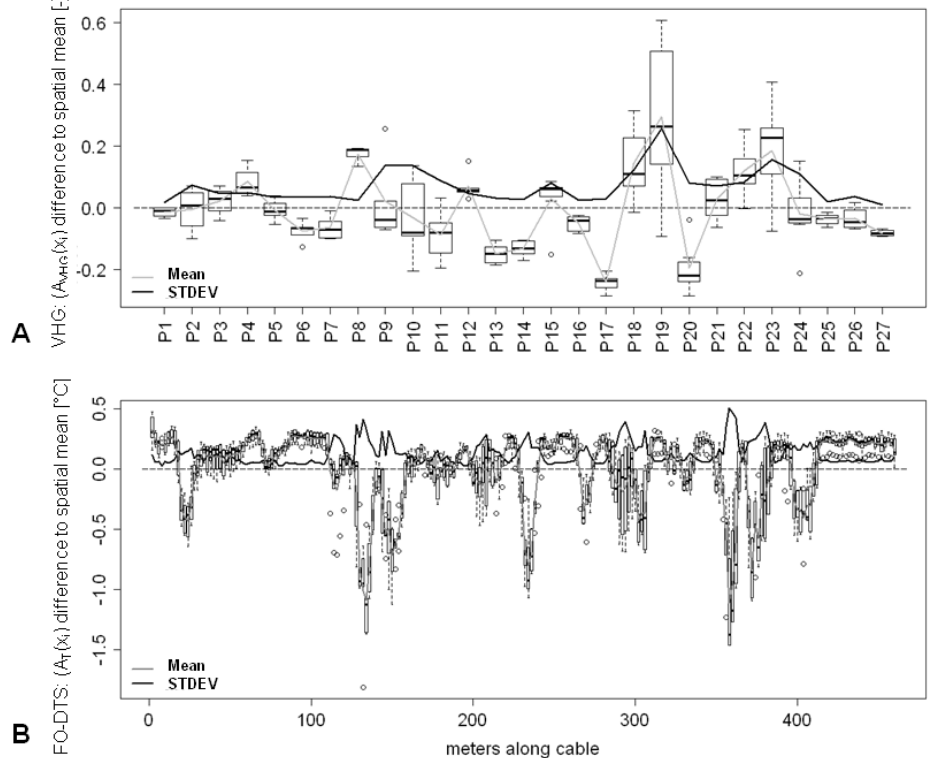
Fig. 8. (A) Box-plots of the temporal and spatial variability of vertical hydraulic gradients along the river reach (north to south) for 4–7 dates (depending on location). Values are standardized by subtracting the spatial mean at each sampling date. (B) Box-plots of the temporal and spatial variability of FO-DTS monitored temperatures along the fibre optic cable for all sampling dates. Values are standardized by subtracting the spatial mean at each sampling